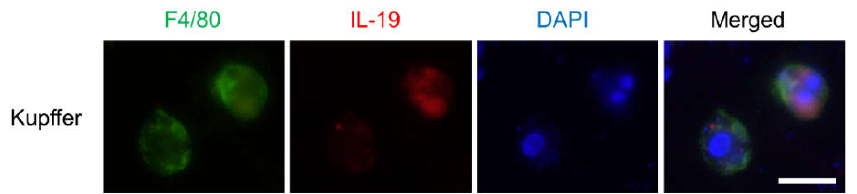
Figure 1. IL-19 expression in the Kupffer cells. Primary Kupffer cells were fixed, then reacted with IL-19 and F4/80 antibodies with DAPI. Representative images were shown ( n = 3). Scale bar represents 50 µ m.